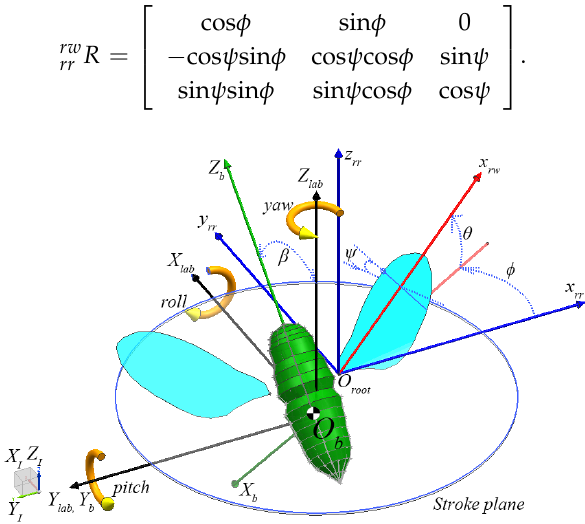
Figure 3. Coordinate systems and definition of right wing Euler angles.